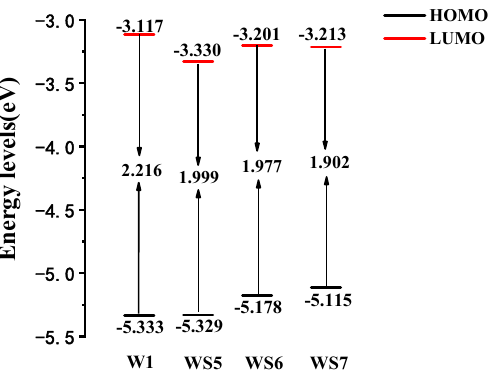
Figure 3. Frontier molecular orbital energy level diagrams of W1, WS5, WS6, and WS7.